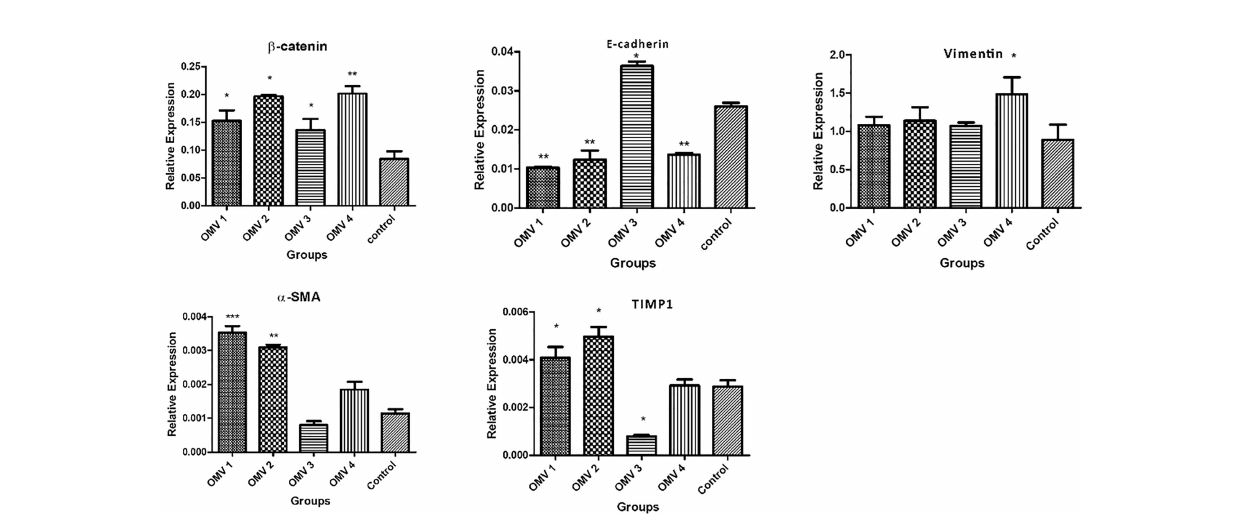
FIGURE 3 | Gene expression of liver fi brosis markers in LX-2 cells upon treatment with 10 µg/ml of H. pylori OMVs. Relative gene expression of fi brosis markers (vimentin, b -catenin, TIMP1, and a -SMA) was markedly increased after treatment of LX-2 cells with 10 µg/ml of H. pylori OMVs. mRNA level of E-cadherin was decreased in LX-2 cells treated with 10 µg/ml of H. pylori OMVs. Data presented as means ± standard error (SEM) for three independent experiments. Data are shown as the mean ± SEM. * P < 0.05, ** P < 0.01, *** P < 0.001 and by post-hoc one-way ANOVA statistical analysis.